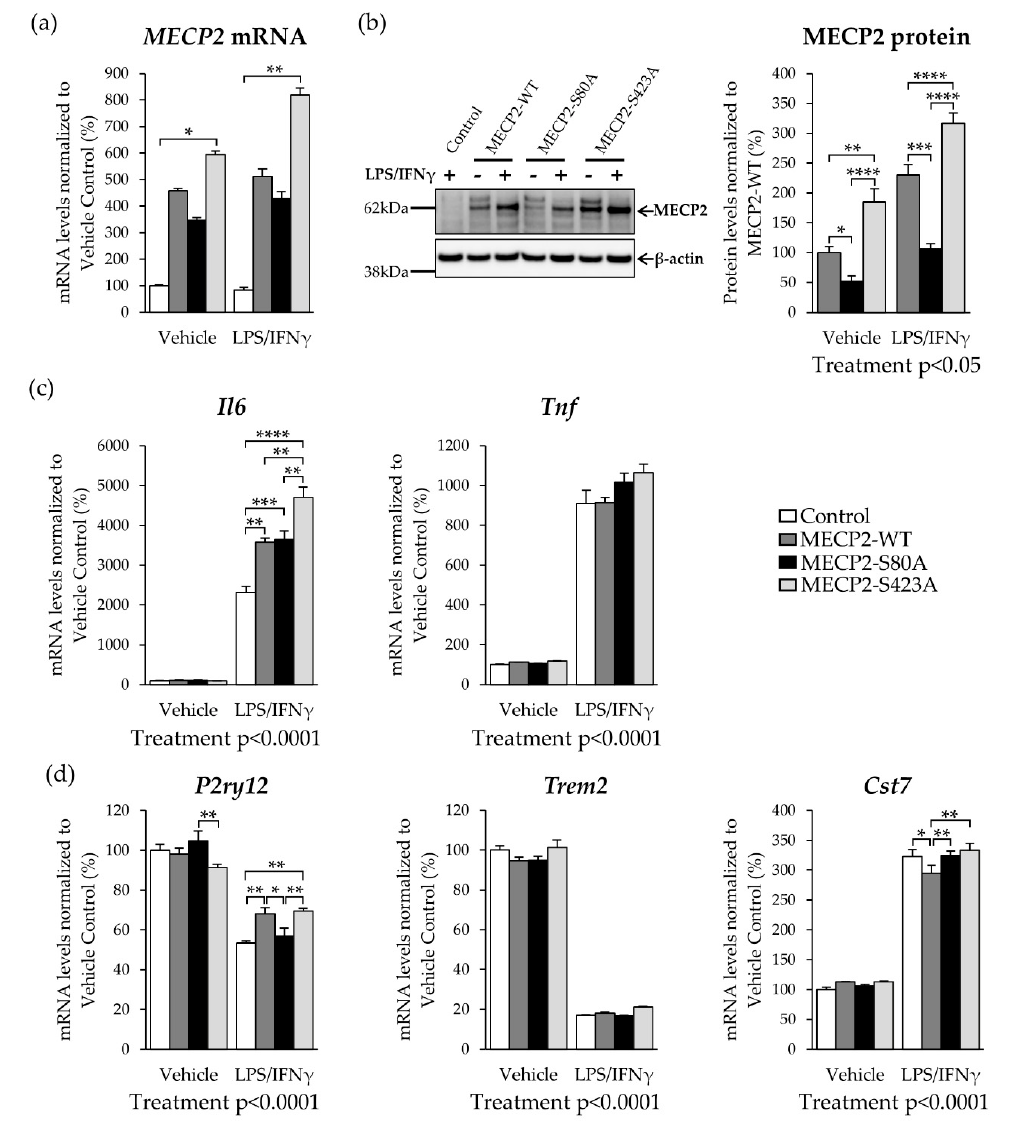
Figure 3. Overexpression of MECP2 phosphorylation-deficient variants increases the expression of pro-inflammatory cytokines in BV2 cells upon LPS/IFN γ -induced inflammation. BV2 cells were transduced with lentivirus vectors encoding MECP2-wild type (WT)-Myc, MECP2-S80A-Myc, MECP-S423A-Myc, or plasmid backbone only (Control). The vector backbone contained the elongation factor-1 alpha (EF1 α ) promoter and green fluorescent protein (ZsGreen1) coding sequence separated by an internal ribosome entry site (IRES). Inflammation was induced by treatment with LPS (200 ng/mL) and IFN γ (20 ng/mL) for 24 h. ( a ) β -actin -normalized MECP2 -WT, MECP2 -S423A and MECP2 -S80A mRNA expression in vehicle and LPS/IFN γ -treated BV2 cells. Data are shown as mean + SEM of n = 4. Kruskal–Wallis followed by Dunn’s multiple comparisons test, ** p < 0.01, * p < 0.05 ( b ) Representative blot image showing MECP2-WT, MECP2-S423A, and MECP2-S80A overexpression in vehicle and LPS/IFN γ -treated BV2 cells (left). Quantification of β -actin normalized exogenous MECP2 protein levels (right). Data are shown as mean + SEM of n = 4. Independent samples t-test; **** p < 0.0001. ( c ) β -actin -normalized mRNA expression of the pro-inflammatory cytokines Il6 and Tnf upon LPS/IFN γ -induced inflammation in BV2 cells expressing MECP2-WT, MECP2-S80A, MECP2-S423A, or Control vector. Data are shown as mean + SEM of n = 4. One-way ANOVA, post-hoc LSD. For Treatment effect: Independent-samples t-test or independent samples Mann–Whitney U test was used; **** p < 0.0001, *** p < 0.001, ** p < 0.01. ( d ) Homeostatic ( P2ry12 ) and disease-associated microglia (DAM; Trem2 / Cst7 ) RNA signature upon LPS/IFN γ -induced inflammation in BV2 cells. Data are shown as mean + SEM of n = 4. One-way ANOVA, post-hoc LSD. For Treatment effect: Independent-samples t-test or independent samples Mann–Whitney U test was used; ** p < 0.01, * p < 0.05.